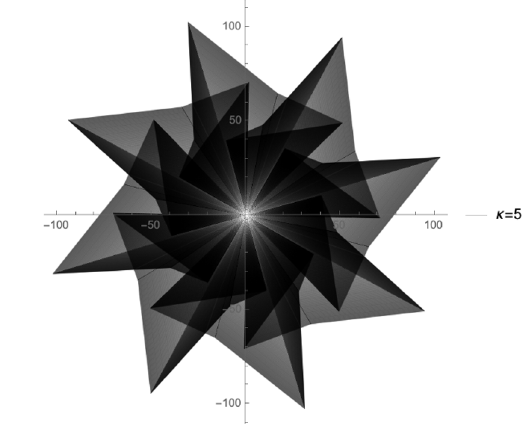
with k = (cid:20) , at (cid:12)xed (cid:20) = 5. Left: m = U(1) ; 1 % p 0 : 03 and % = 1 ; : : : ; 2 (cid:2) 10 4 .